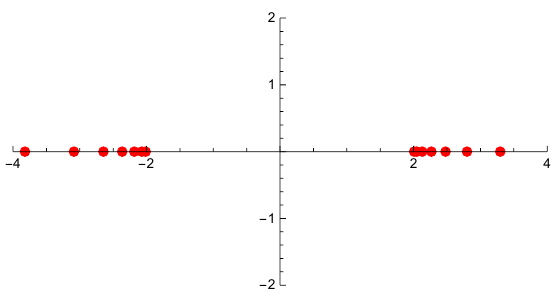
Figure 2 . In this (cid:12)gure we show the poles of the Borel-Pad(cid:19)e transform of the (cid:12)rst 44 terms of the perturbative series (2.77) for the O( N ) sigma model with N = 4. We consider the Pad(cid:19)e approximant (21 ; 21). The poles accumulate in two branch cuts starting at the singularities (cid:16) = corresponding to the (cid:12)rst IR and UV renormalons,